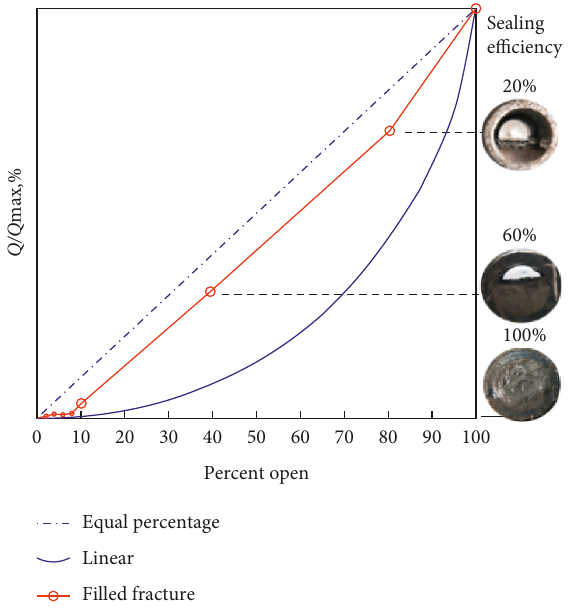
Figure 8: Flow characteristics of valves and filled fractures. For fractures, percent open refers to the ratio of an unfilled section to the whole section of the fracture.